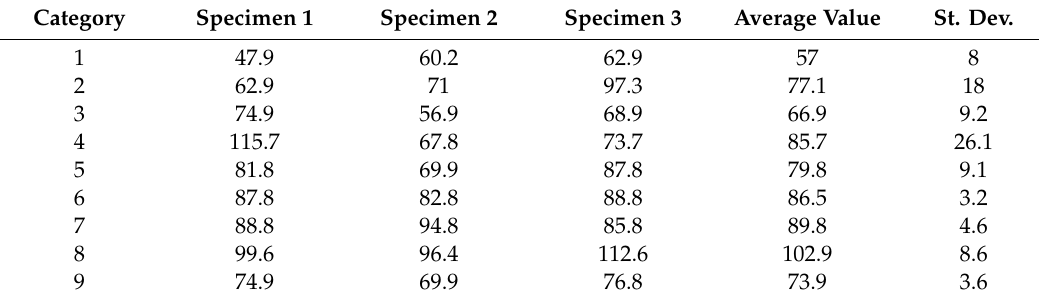
Table 2. Experimental flexural strength (MPa) for the di ff erent specimens.